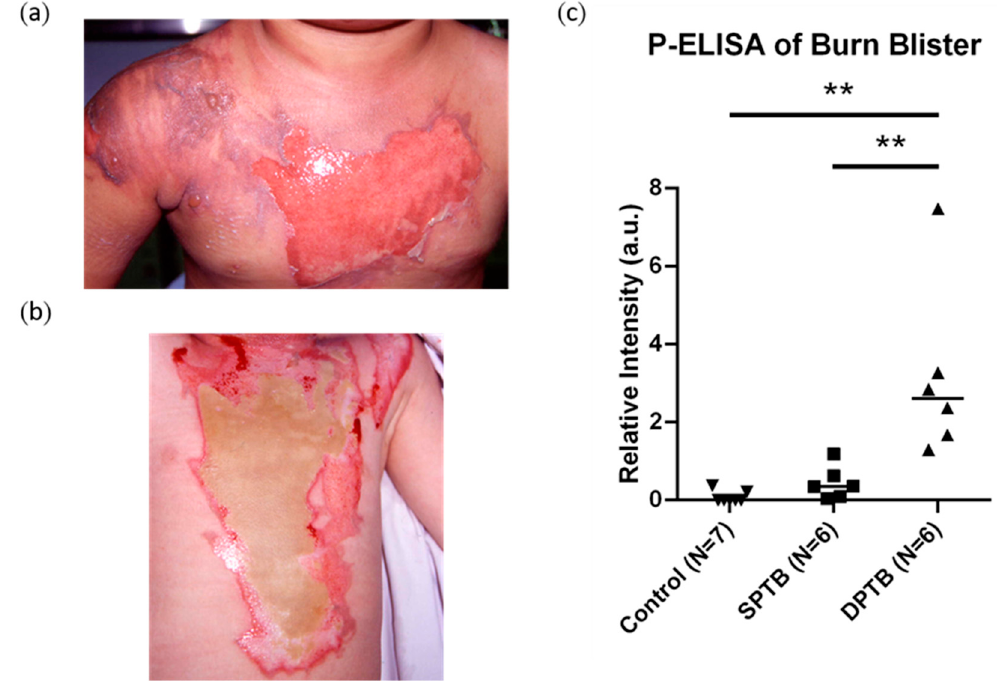
Figure 2. Analysis of angiogenin levels from superficial partial-thickness burn (SPTB) and deep partial-thickness burn (DPTB) blister fluids using P-ELISA. ( a , b ) Clinical pictures of superficial partial-thickness burn (SPTB, a ) and deep partial-thickness burn (DPTB, b ) wounds. ( c ) Comparison of angiogenin levels from two different burn fluids and healthy human blood serum as the control ( n = 6 in SPTB and DPTB, n = 7 in control, mean ± S.D, ** p < 0.01).